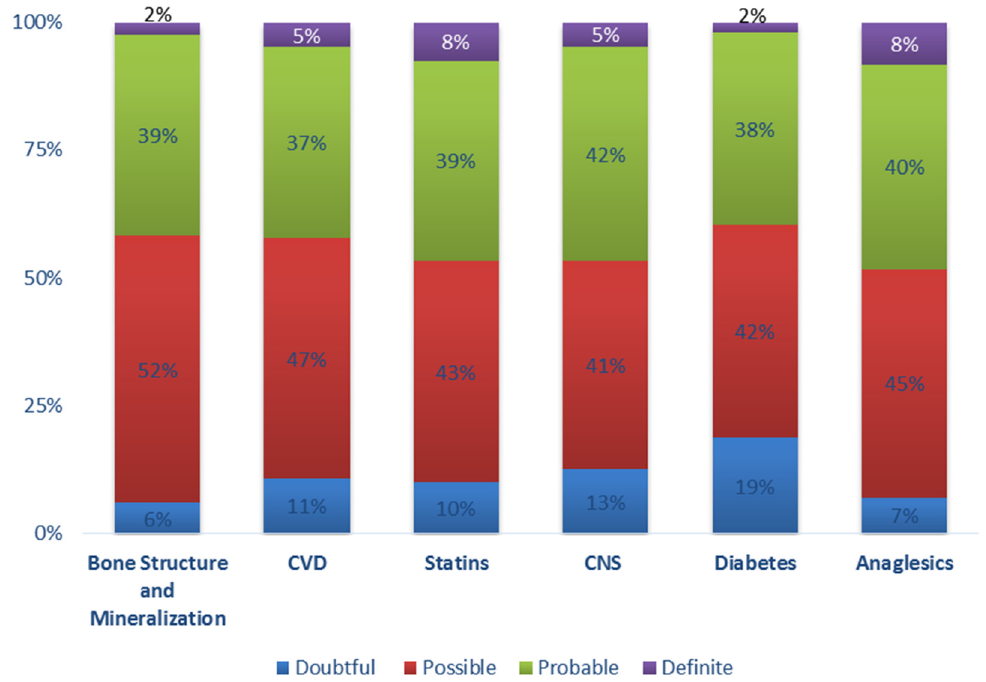
Figure 4. Naranjo scale results for different drug categories prescribed in ESRD patients of the study (CNS: central nervous system drugs including antiepileptics, antipsychotics, antidepressants, anti-parkinson; CVD: cardiovascular disease drugs, including antiplatelet–anticoagulant).